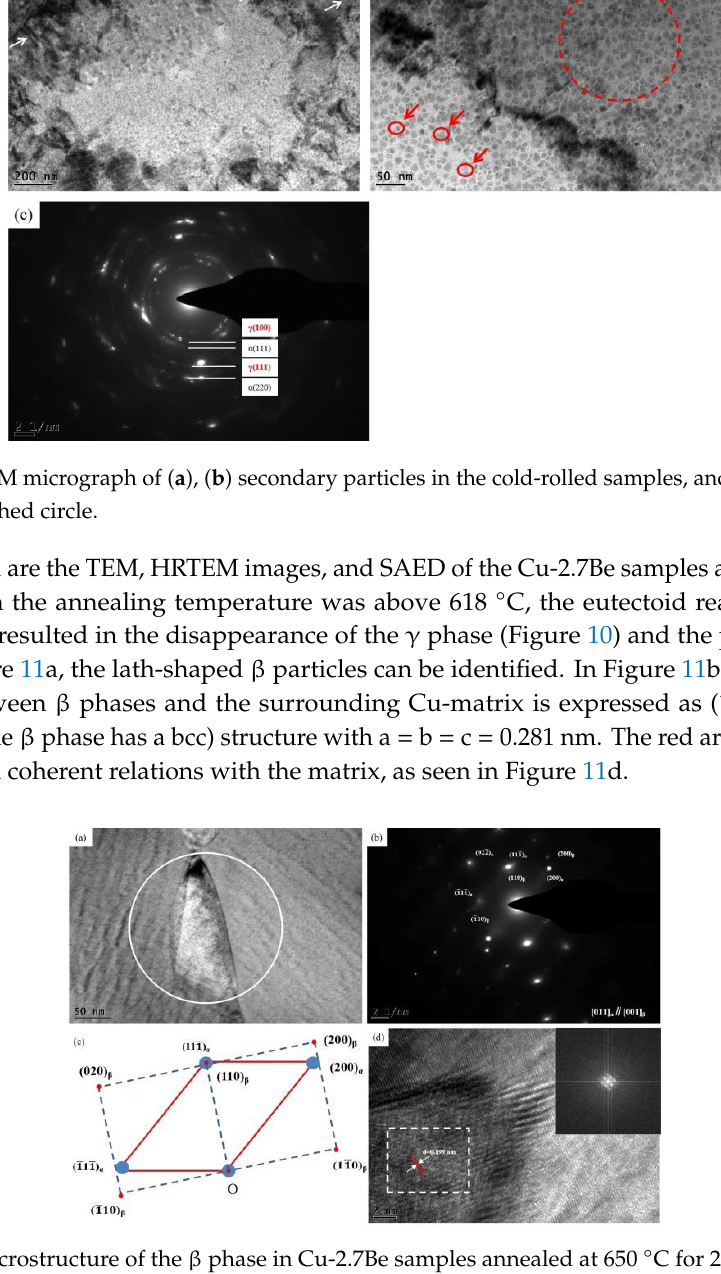
Figure 11. Microstructure of the β phase in Cu-2.7Be samples annealed at 650 °C for 2 min: ( a ) TEM image; ( b ) the SAED of white circle area in ( a ); ( c ) schematic representation of ( b ); ( d ) high resolution transmission electron microscopy (HRTEM) image of ( a ), the inset show the Fast Fourier Transform (FFT) of rectangular region.